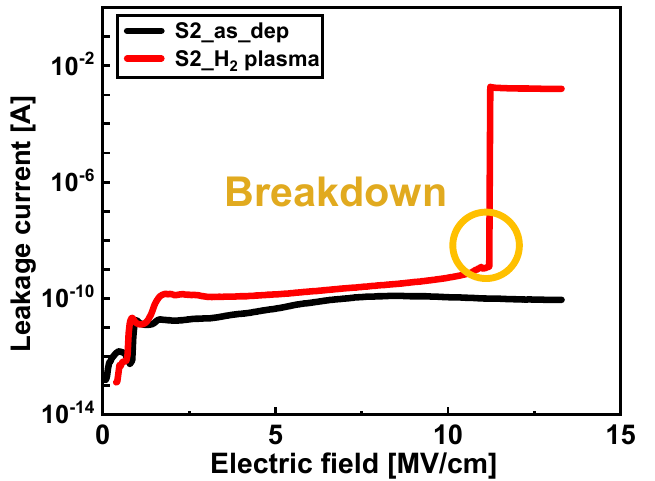
Figure 9. C–V hump effect (yellow circle) owing to excessive H 2 plasma treatment in the normalized capacitance vs. voltage curves of Al 2 O 3 films with an increased O 2 plasma exposure time (frequency = 1 MHz).